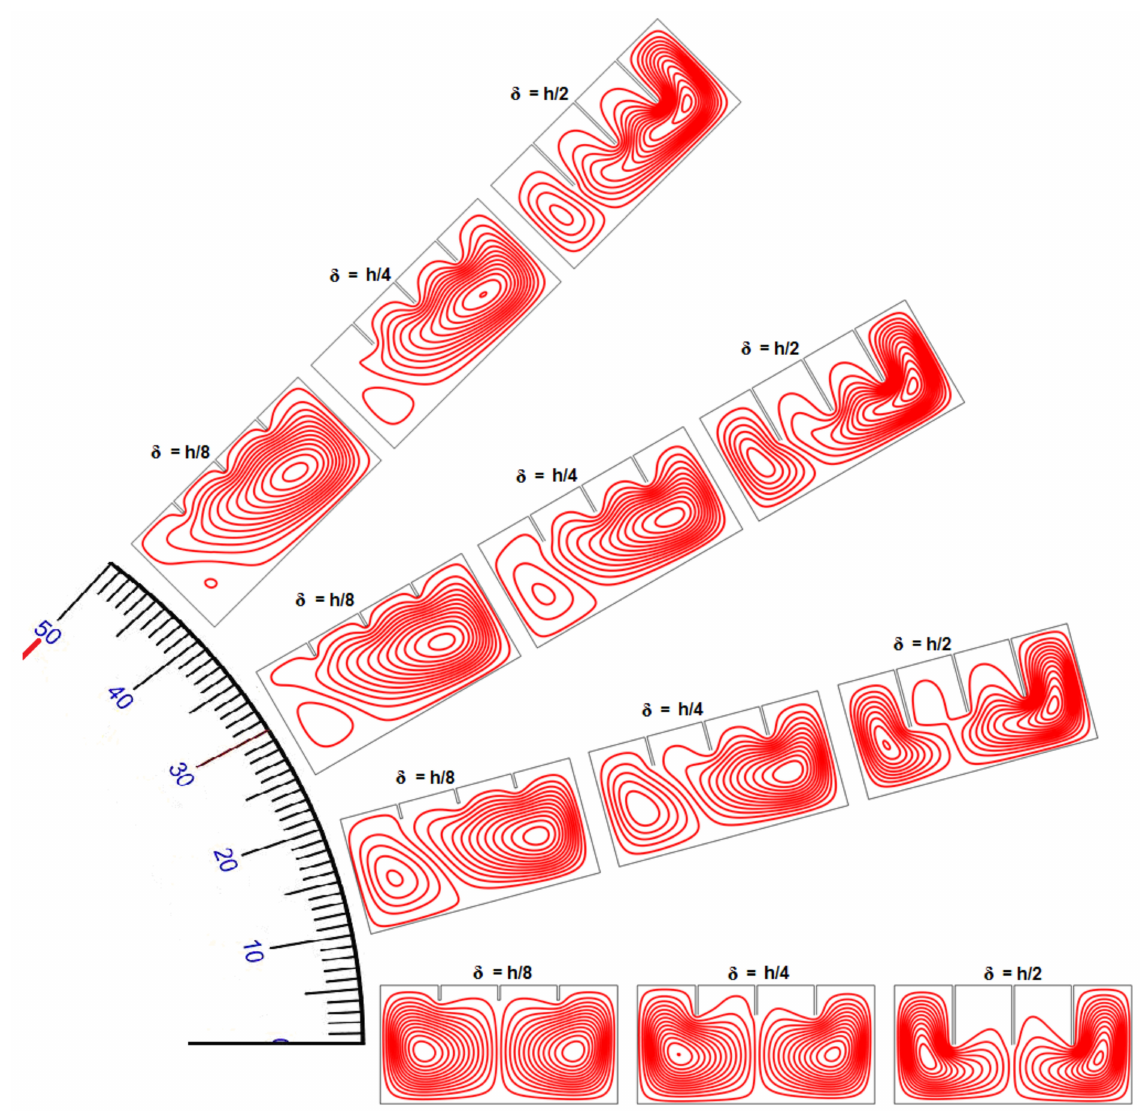
Figure 12. Effects of fin height and enclosure inclination angle on nanofluid